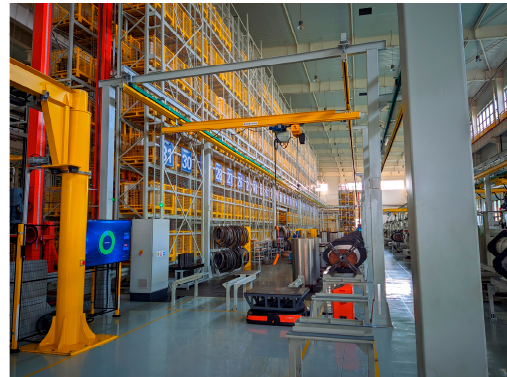
Figure 6. Intelligent warehousing logistics transportation.